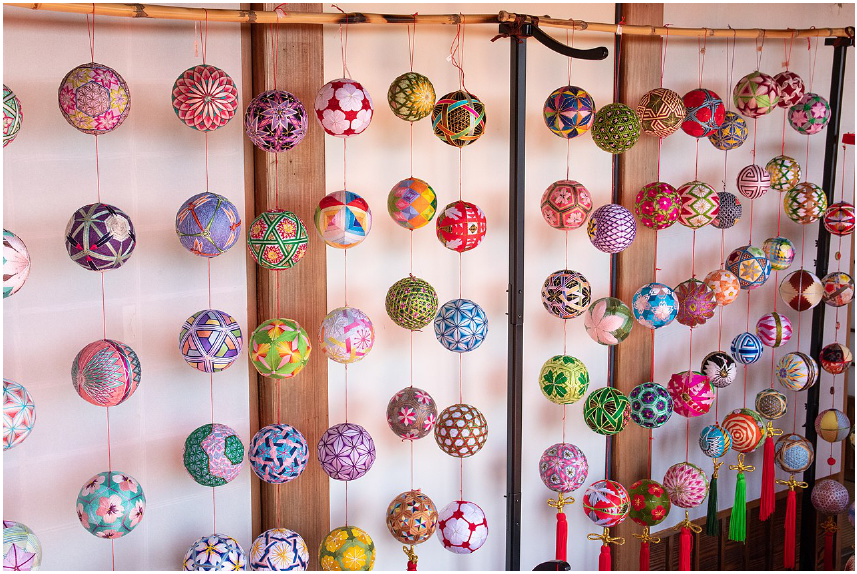
Figure 1. A collection of Temari balls. Credits: Wikipedia, user Σ 64, license CC BY